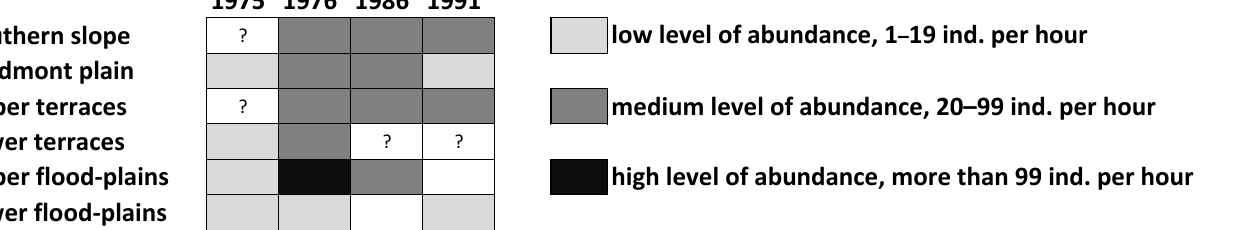
Figure 3. Population distribution of the Italian locust along the local transect crossing the Ayagöz River Valley (semi-desert, eastern part of the Kazakh Uplands, 47.92 ◦ N 80.25 ◦ E). Collectors: 1975—I. Stebaev, E. Moiseeva; 1976—A. Lopatkin; 1986 and 1991—M.